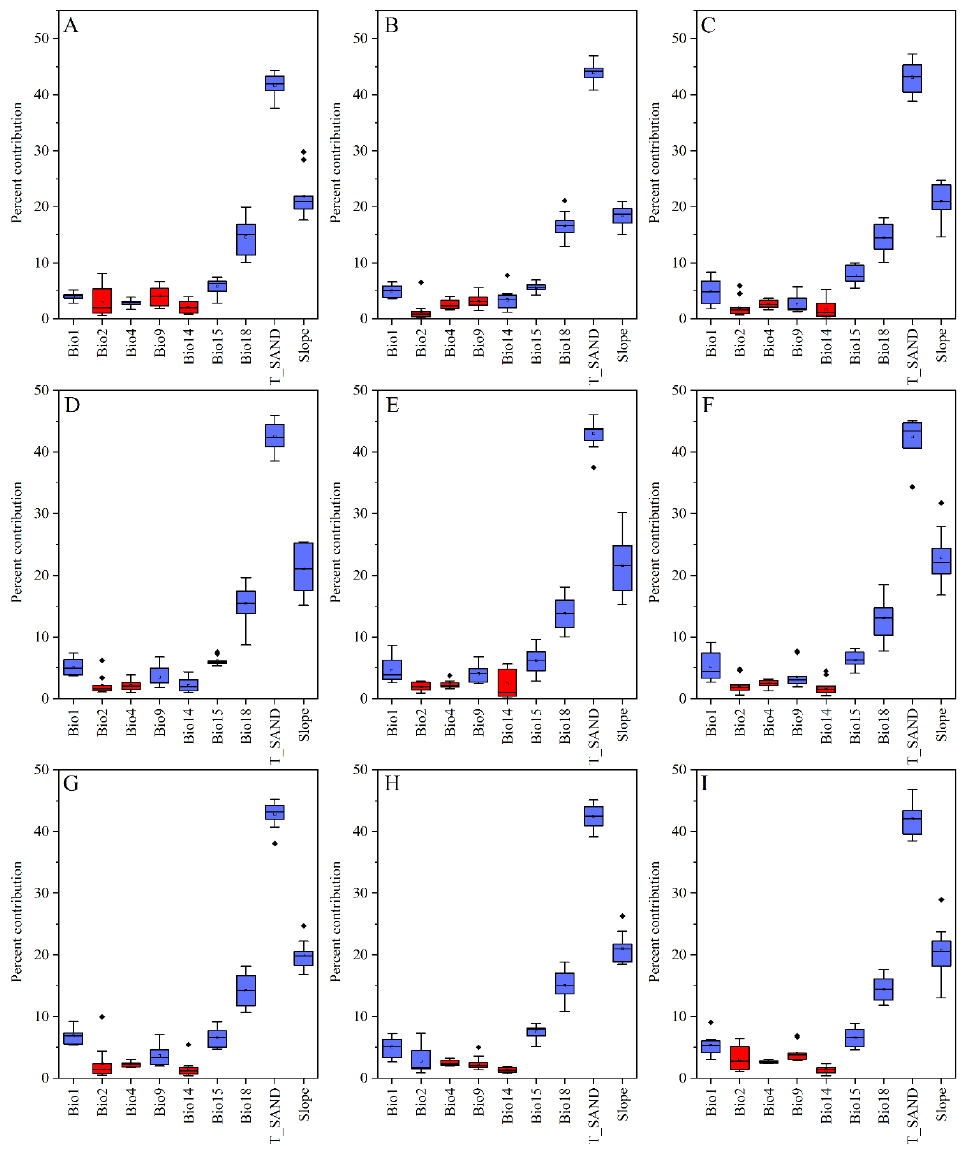
Figure 2. ( A ) – ( I ) Represent the percentage contribution of nine environmental variables (Bio1, Bio2, Bio4, Bio9, Bio14, Bio15, Bio18, T-SAND and Slope) in the MaxEnt model for the current time period and for different paths in the 2030s and 2050s (SPP126, SSP245, SSP370, SSP585). The box plots show the median (horizontal line inside the box), first and third quartiles (upper and lower edges of the closed box), and the maximum and minimum values (ends of the box whiskers). Outlier values more than 1.5 times the interquartile range are depicted as circles, and values more than three times the interquartile range are denoted as stars. The blue boxplot represents environmental variables with high contribution rates, and the red boxplot represents environmental variables with low contribution